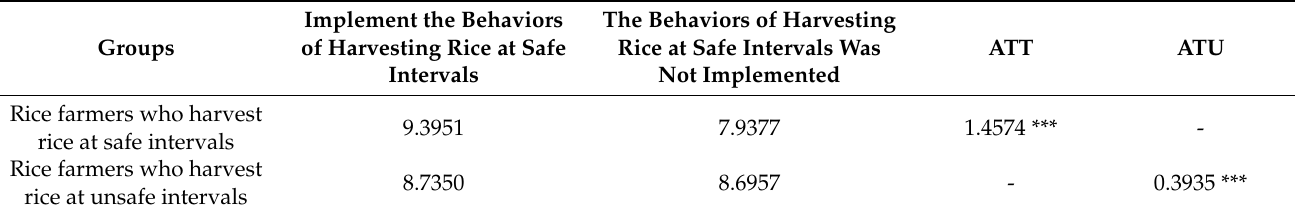
Table 8. Average treatment effect of rice farmers’ choice of rice harvesting behaviors in safe interval on rice income and output.